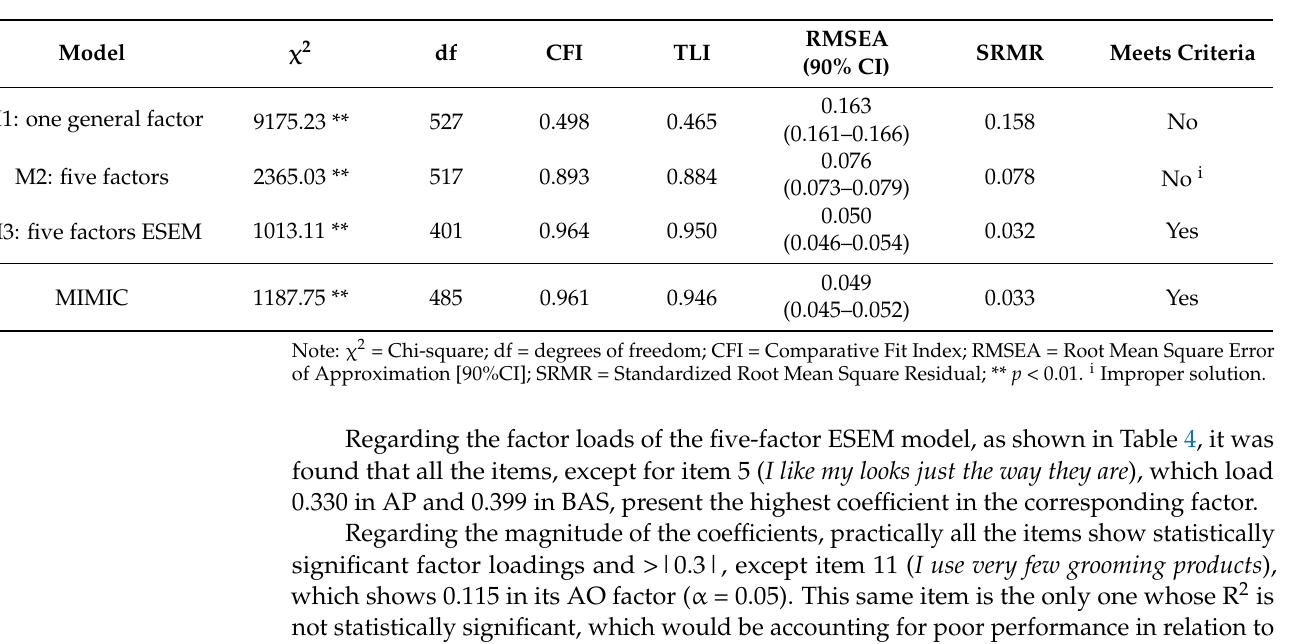
Table 3. Models fit